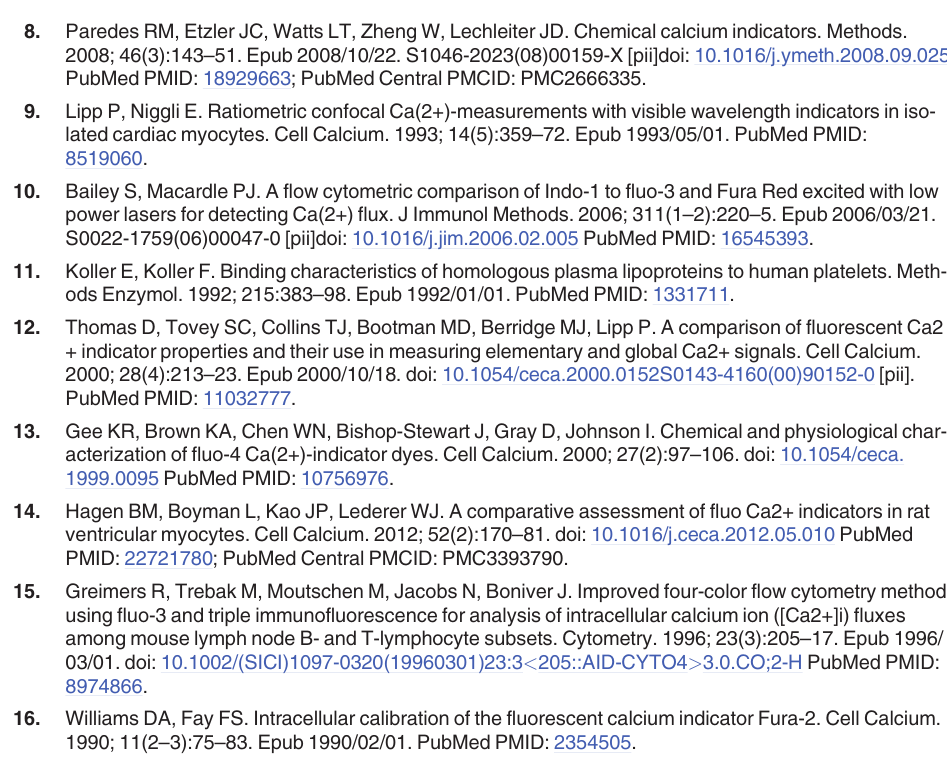
PLOS ONE | DOI:10.1371/journal.pone.0122527 April 7,